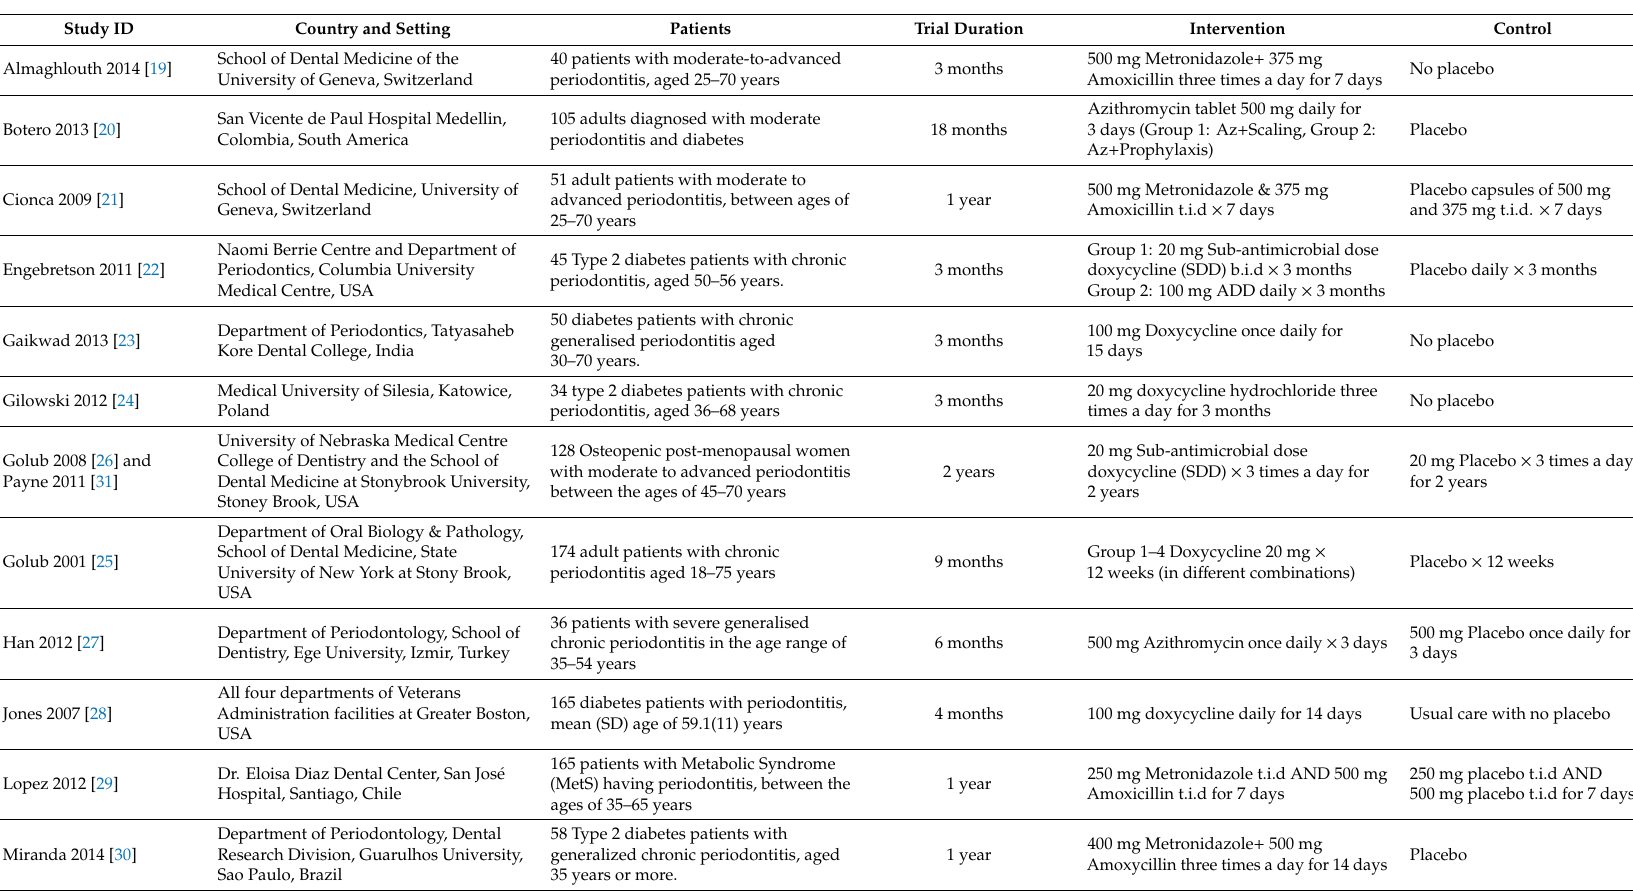
Table 1. Characteristics of included studies on the e ff ect of antibiotics in addition to mechanical debridement among adults with chronic